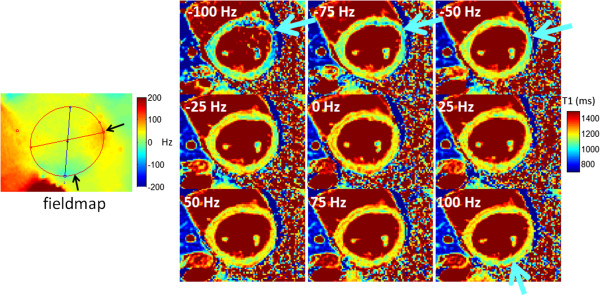
T1-maps acquired at different center frequencies using MOLLI 5s(3s)3s at 3 T. Despite the use of a 2nd order shim in a local volume around the heart, off-resonance variation across the heart, as seen in the field map (left), leads to an artifactual local variation in the apparent T1 as indicated by arrows [42]. (adapted from http://www.jcmr-online.com/content/15/1/63/figure/F5 and http://www.jcmr-online.com/content/15/1/63/figure/F6).